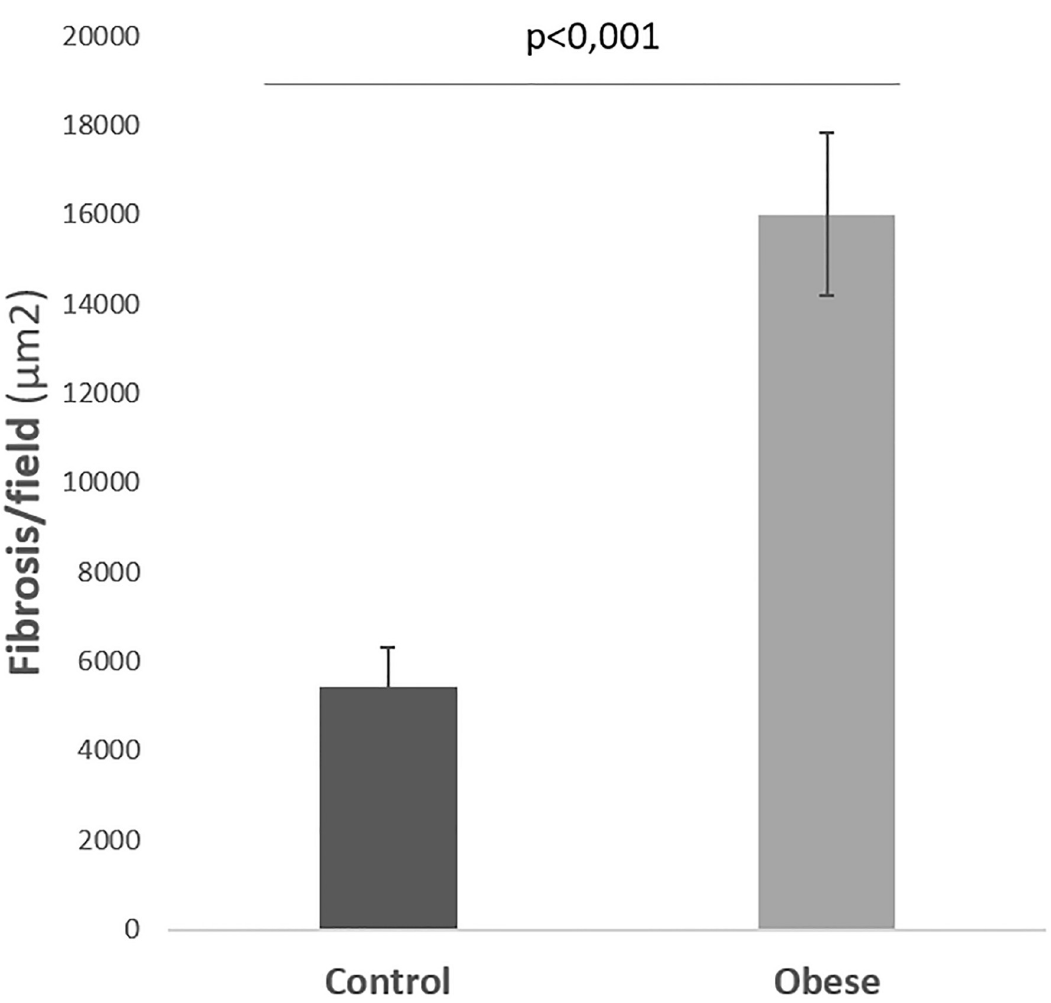
Fig 6. Mean surface area of liver fibrosis in the control group and obese